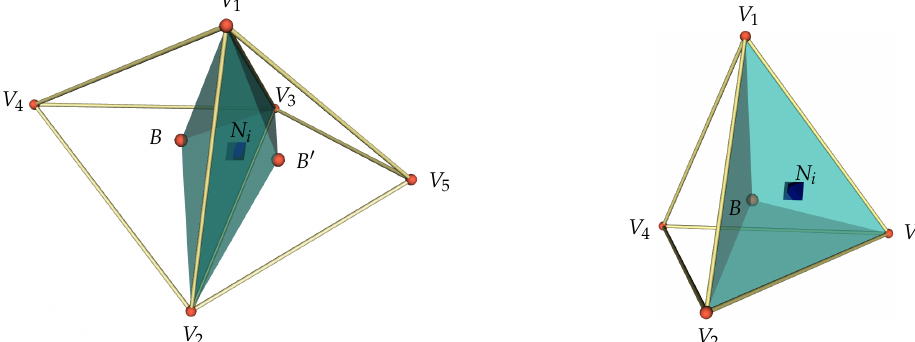
Figure 2. Staggered dual mesh in 3D. Left: interior finite volume. Right: boundary finite volume.